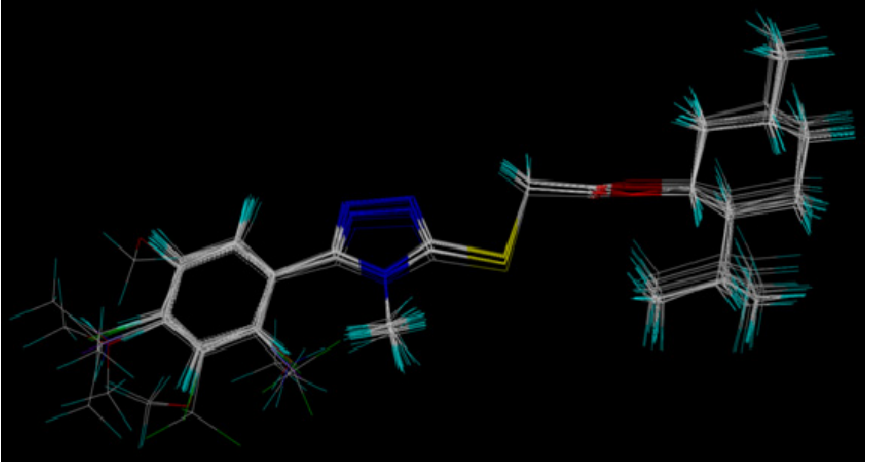
Figure 5. Superposition modes of compounds .